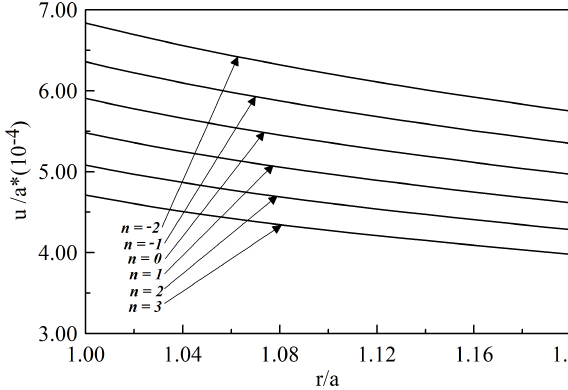
Figure 39: Radially distributed tangential stress